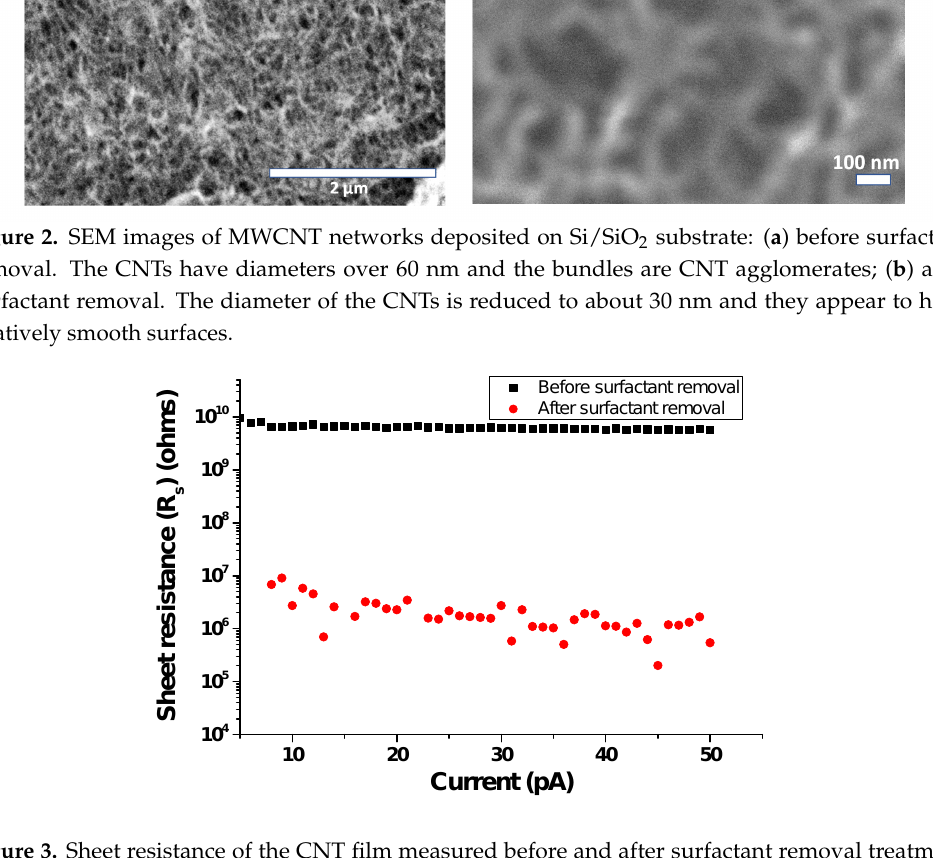
Figure 3. Sheet resistance of the CNT film measured before and after surfactant removal treatment. R s decreased about four orders of magnitude after